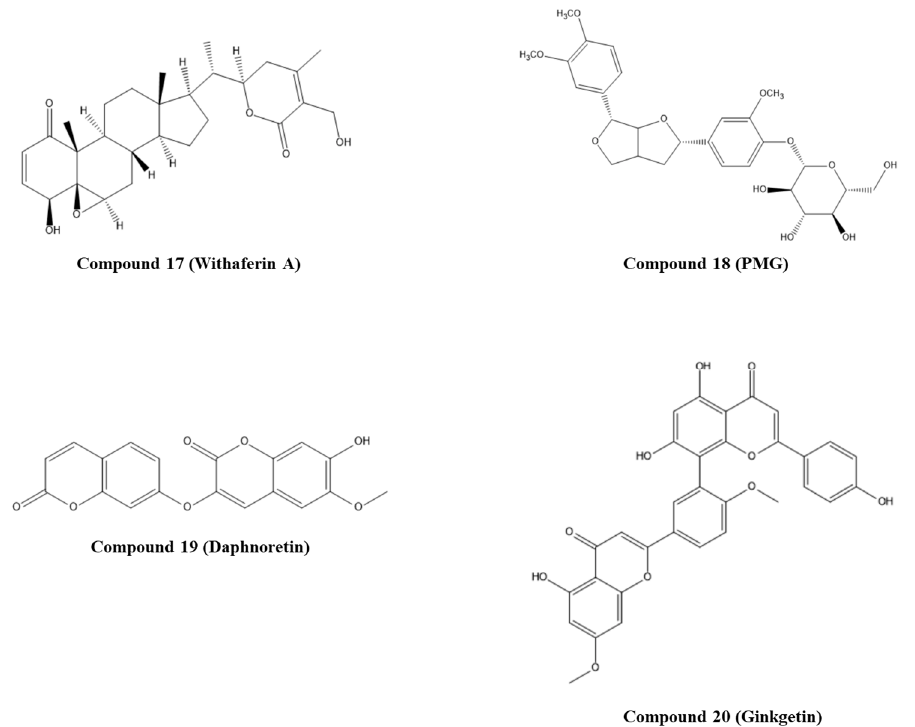
Figure 5. Structures of the studied natural compounds as E6/p53 inhibitors. IUPAC name of compounds—compound 17